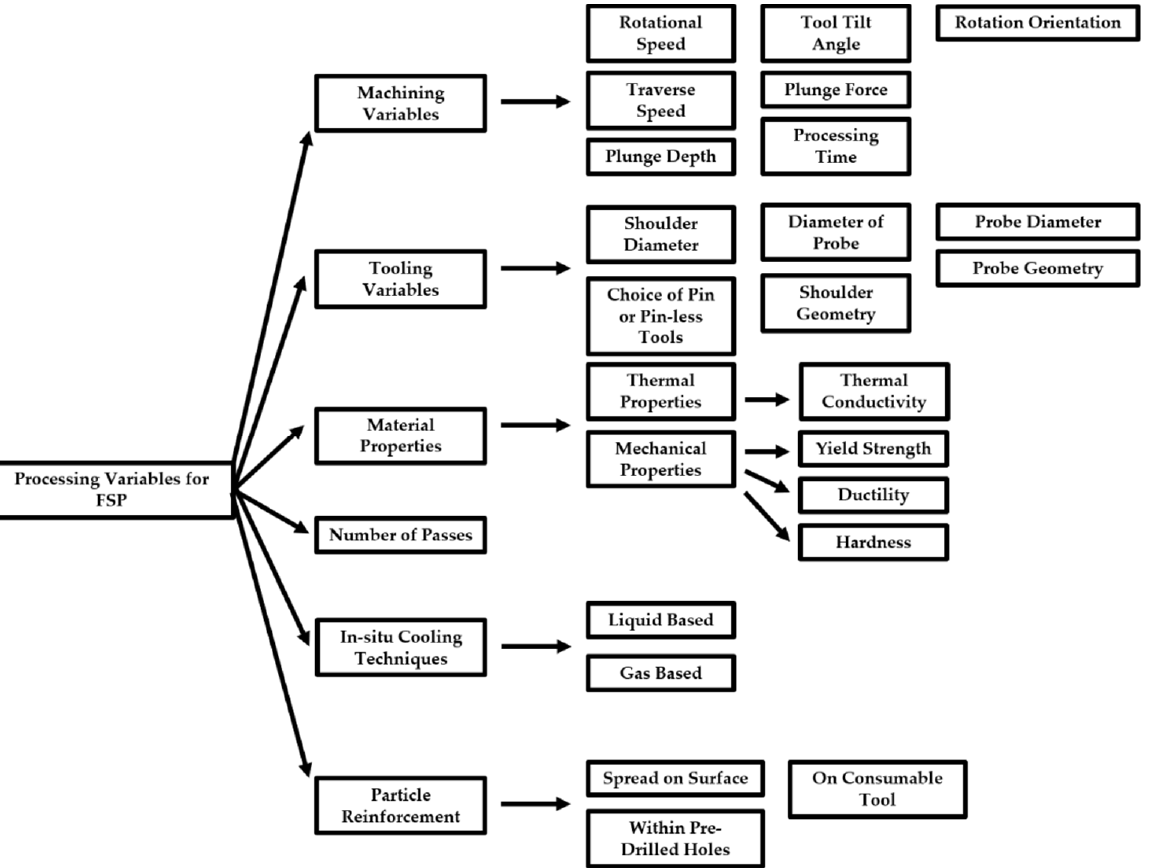
Figure 2. A detailed depiction of the effects of different processing variables on FSP steels.